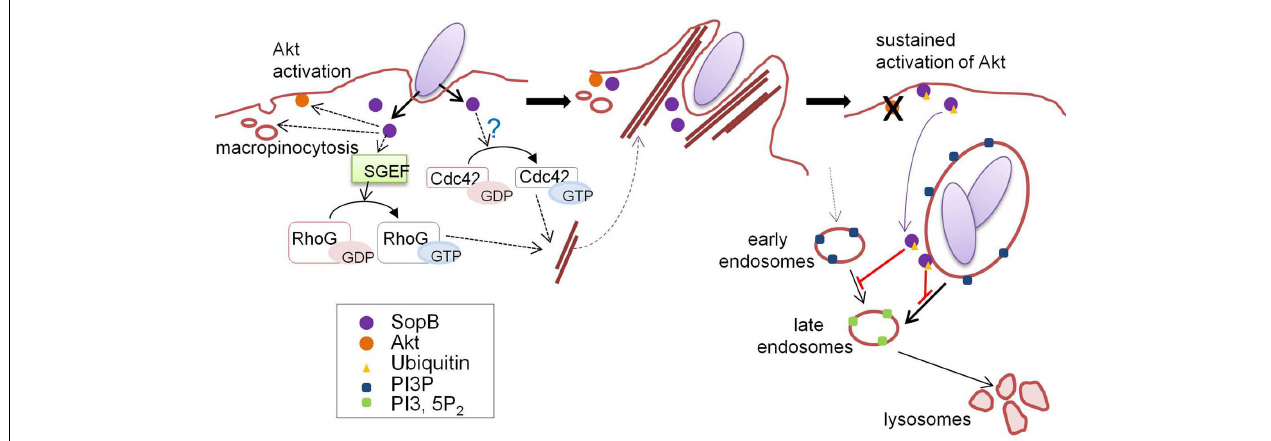
reorganization to form “membrane ruffles” which enable bacteria to be internalized into host cells (middle panel). SopB is monoubiquitinated by the function of an unknown host ubiquitin ligase, and ubiquitinated SopB is then removed from the plasma membrane and recruited to the SCV, where SopB functions to modulate vesicular trafficking by altering phosphoinositide metabolism (right panel).This figure is adopted from Patel et al.